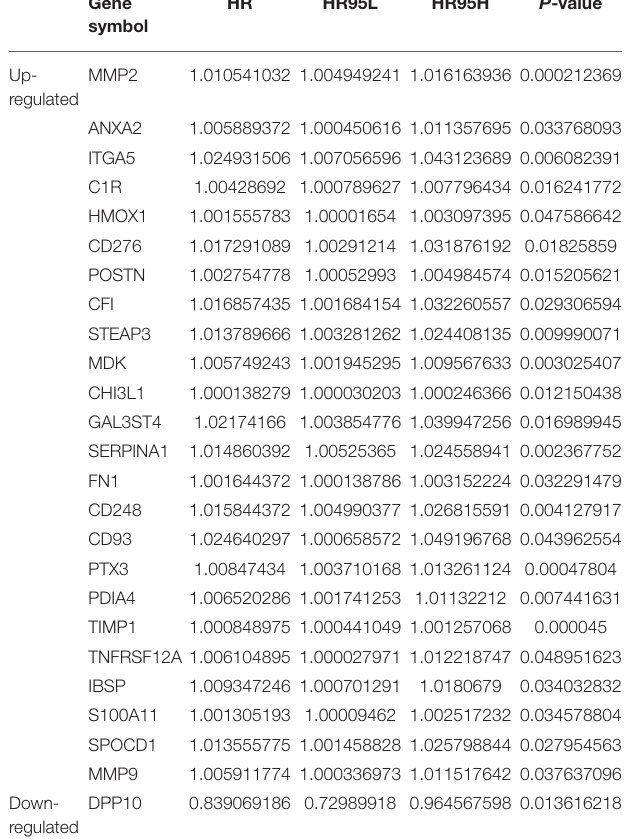
TABLE 1 | Survival analysis of the